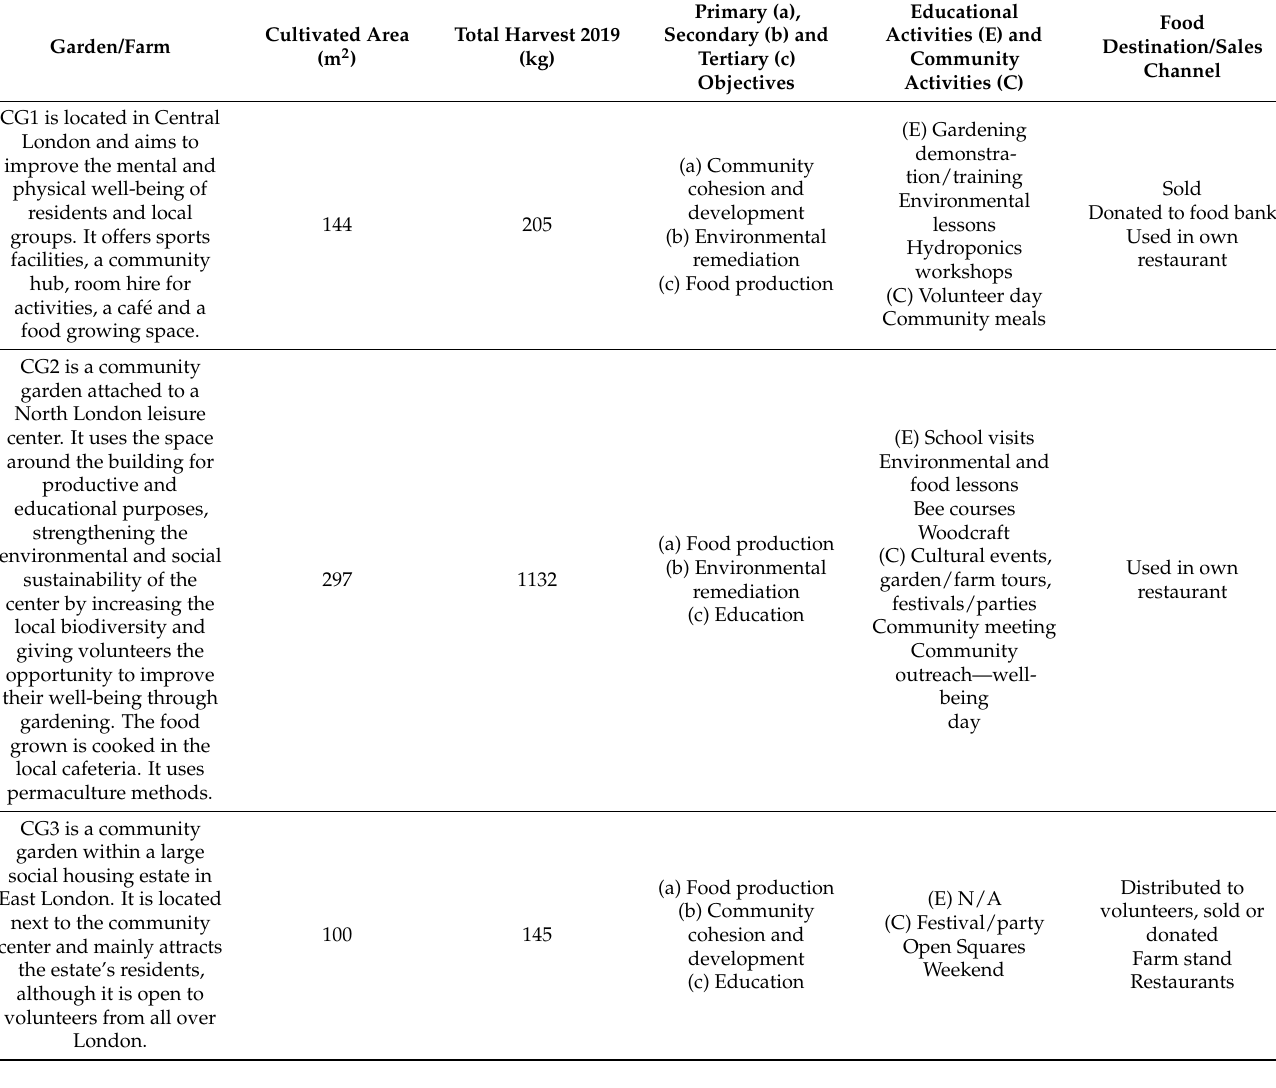
Table 2. Profile of the case